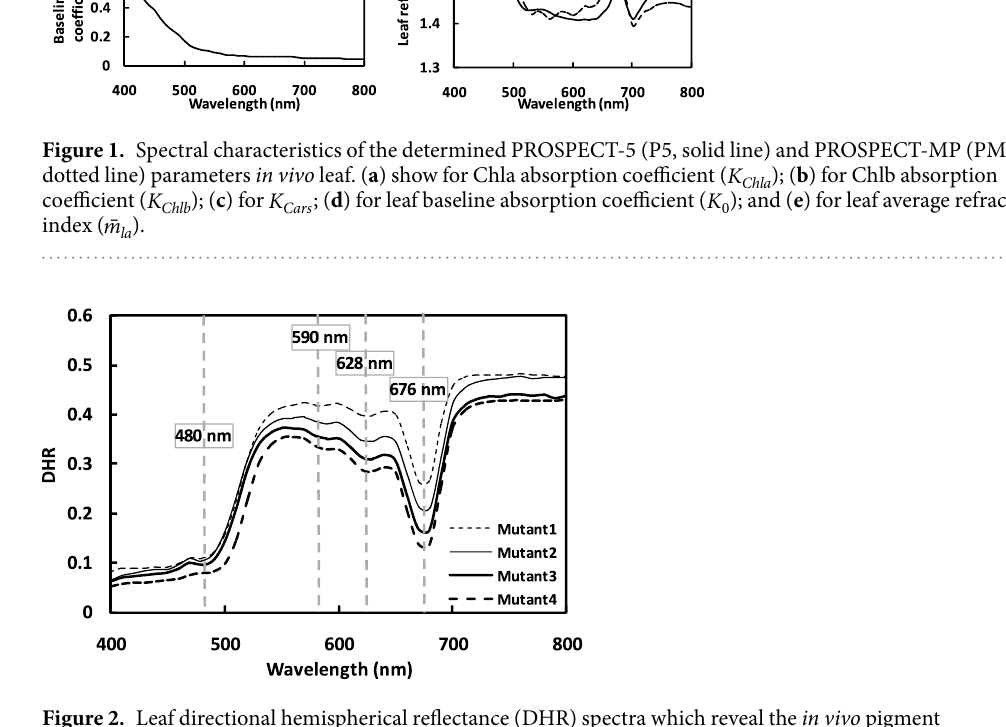
Figure 2. Leaf directional hemispherical reflectance (DHR) spectra which reveal the in vivo pigment absorption characteristics (Mutant1 = 11.864 μ g/cm 2 ; Mutant 2 = 15.452 μ g/cm 2 ; Mutant3 = 20.521 μ g/cm 2 and Mutant4 = 27.944 μ g/cm 2